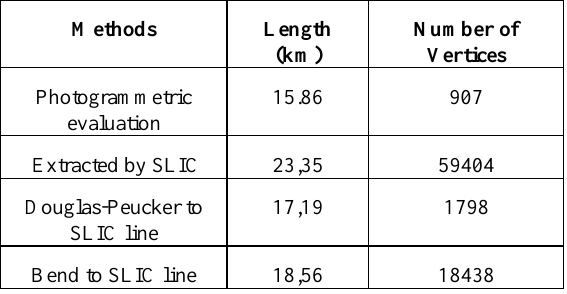
Table 2. Total length and the number of vertices of shoreline.